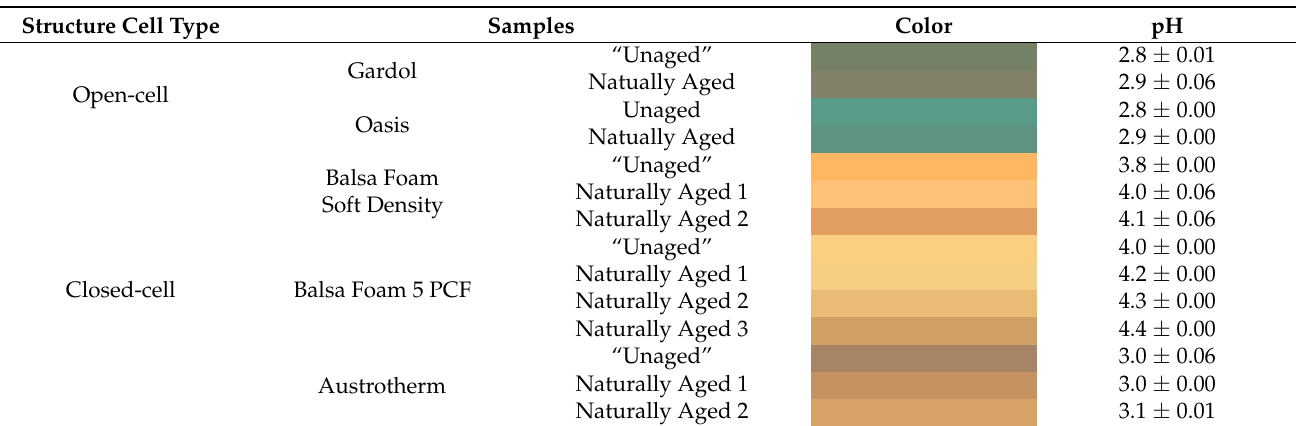
Table 5. pH values and their standard deviations registered for the “Unaged” and Naturally Aged open- and closed-cell type of phenol formaldehyde (PF) foams. Structure Cell